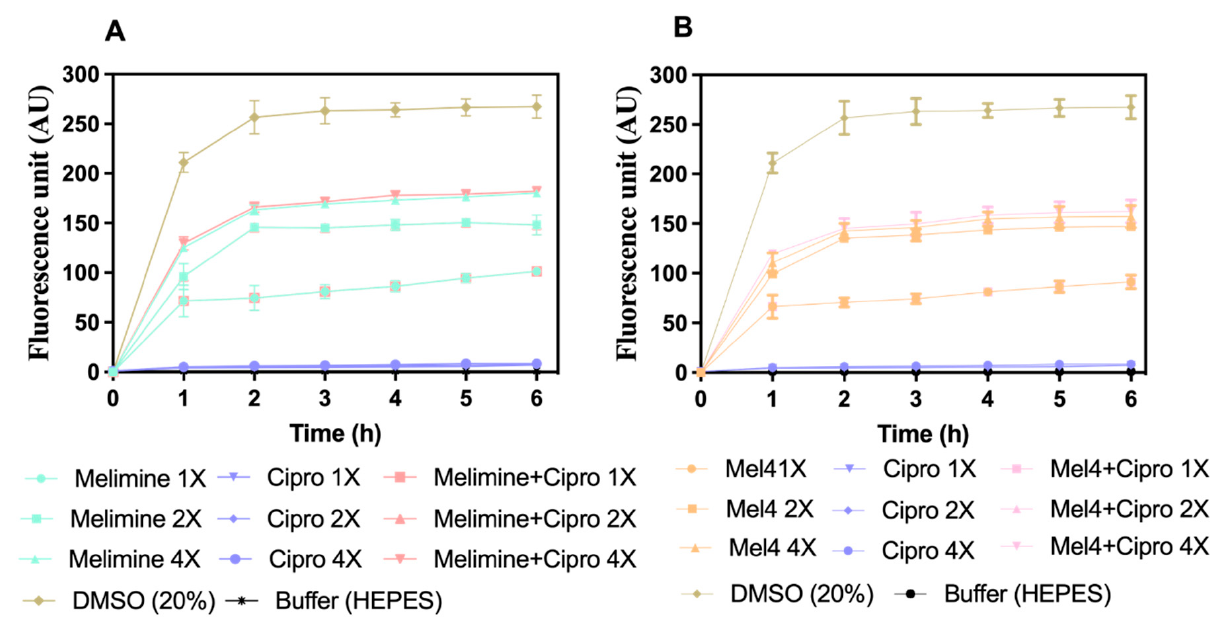
Figure 6. Cell membrane depolarization of pre-formed (24 h) biofilm cells. Cell membrane depolarization of S. aureus ATCC 25923 (became resistant to ciprofloxacin after 30 days of serial passages at sub-MIC) ( A ) by melimine and ciprofloxacin alone or in combination, and ( B ) by Mel4 and ciprofloxacin alone or in combination against pre-formed (24 h) biofilms. Error bars are means ( ± SD) of three independent repeats in triplicate. Cipro = ciprofloxacin, DMSO = dimethyl sulfoxide.